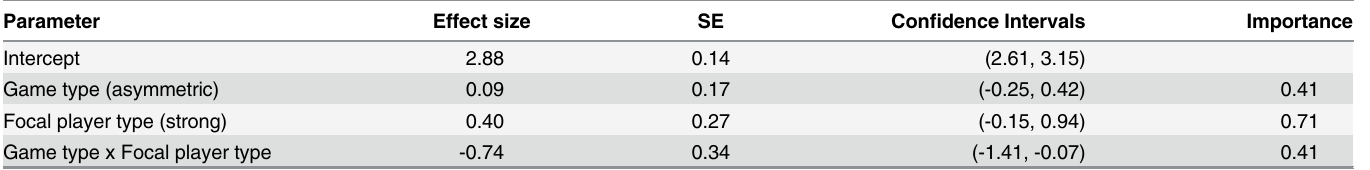
Table 3. Mean cooperation levels.